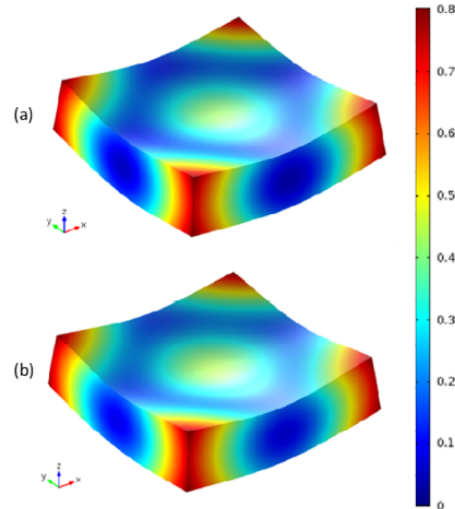
Figure 13. Contours of the deformation after cool-down forecasted by ( a ) Viscoelastic model, ( b ) Modified CHILE model.